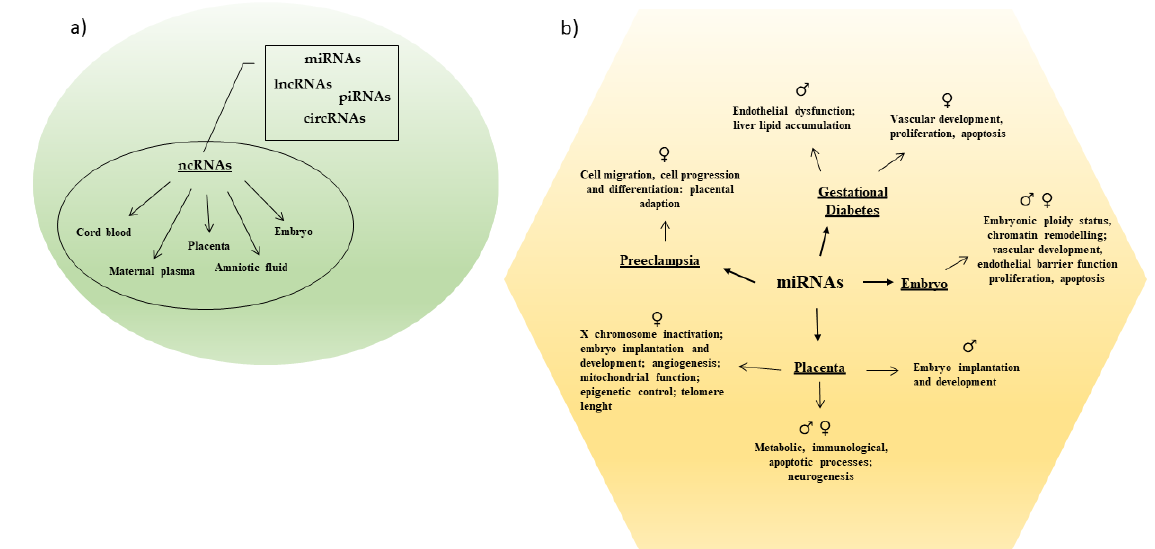
Figure 1. ( a ) Different categories of ncRNAs have been detected in maternal and fetal body tissues. ( b ) Sex-specific miRNAs regulate several processes in pregnancy and pregnancy related